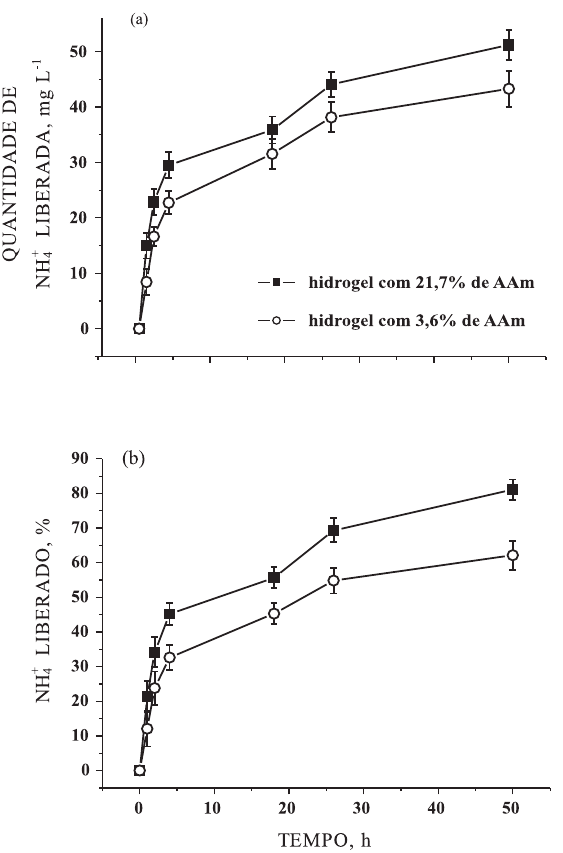
Figura 5. Perfil de liberação controlada de NH 4+ contido em sulfato de amônio em função do tempo a partir de hidrogéis de